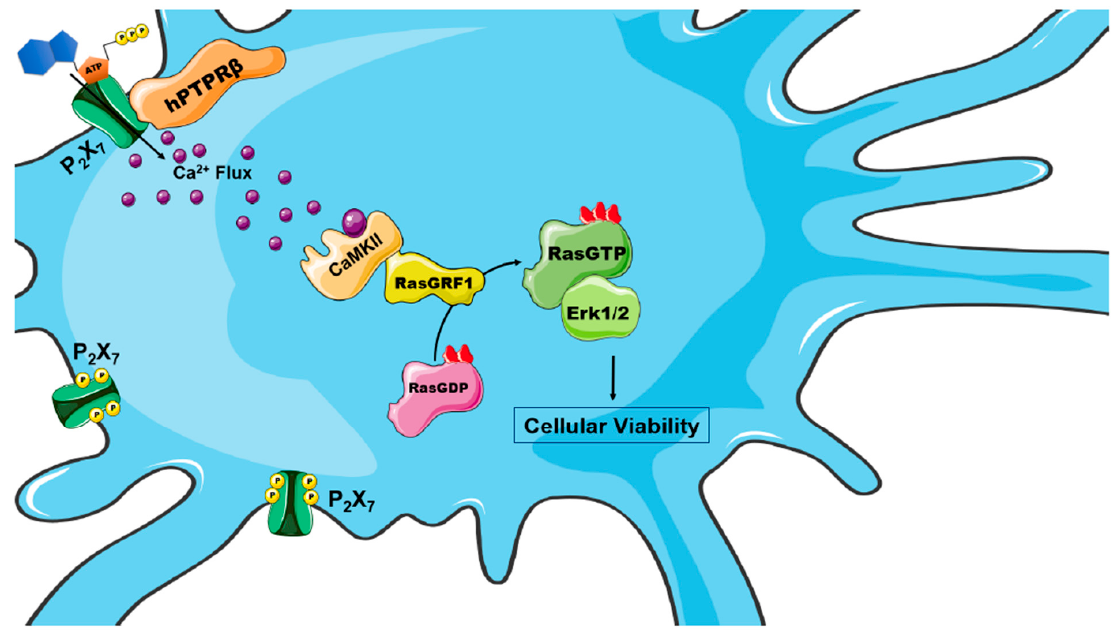
Figure 6. Low ATP concentrations promote cell survival via the CamKII/RasGRF1/RasGTPase/Erk pathway via the P2X 7 /hPTPB receptor system in SN4741 dopaminergic neurons. Scheme of the signaling cascade promoted by ATP stimulation of CamKII/RasGRF1/RasGTPase/Erk via the P2X 7 receptor that promotes cell survival in SN4741 dopaminergic neurons. Low concentrations of extracellular ATP activate the P2X 7 receptor. In a basal state of activation, the P2X 7 receptor is phosphorylated. Due to the action of hPTPB tyrosine phosphatase, the P2X 7 receptor is dephosphorylated, causing a greater flow of calcium, that promotes the activation of CamKII. Active CamKII binds to IQ domain of the RasGRF1 nucleotide exchanger. RasGRF1 promotes the change of RasGTPase from the inactive state (GDP-bound Ras) to the active state (GTP-bound Ras). Activated Ras can activate its main effector molecule Erk1/2. According to our results presented here, this described signaling cascade is involved in the cell survival of SN4741 dopaminergic